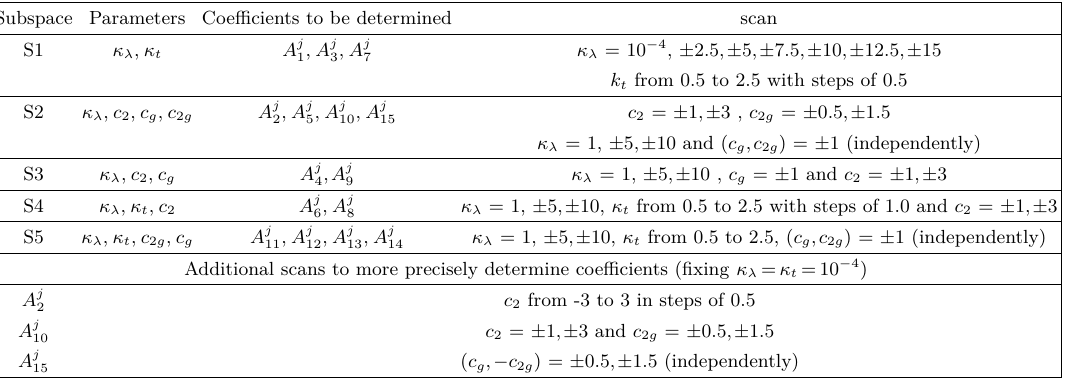
Table 9 . Definition of the lower dimensional subsets (S k ) to find the coefficients of equation